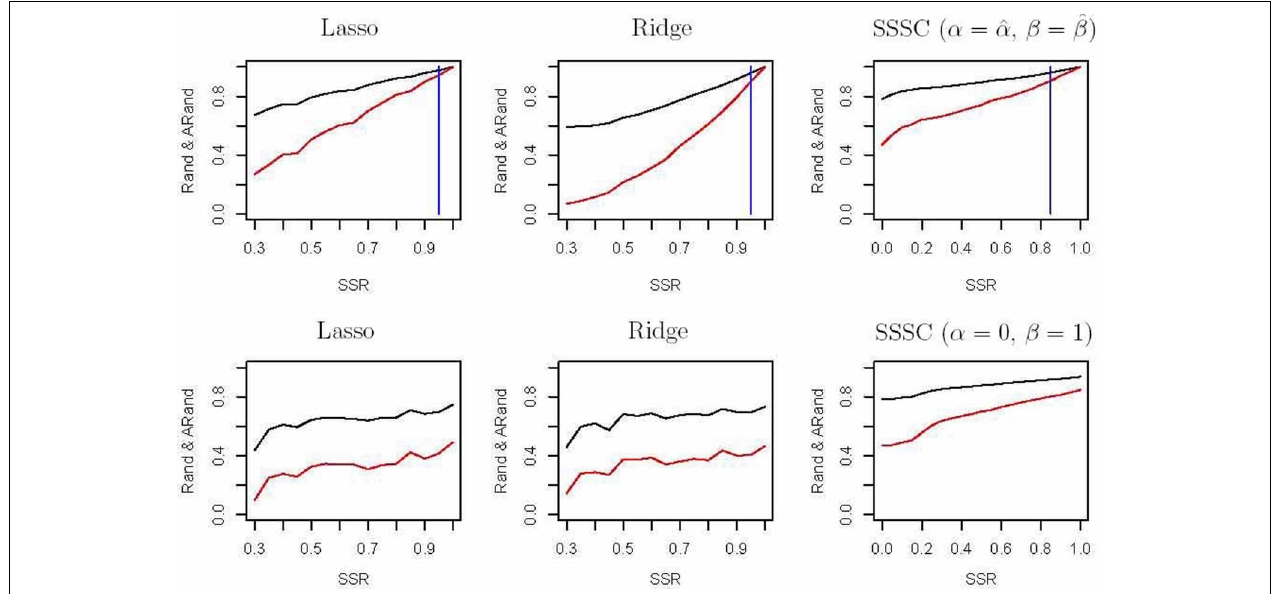
FIGURE 4 | Rand indices (black) and adjusted Rand indices (red) between the true subgroups and the SSSC or classification results. A vertical blue line indicates the point of SSR, at which the Rand and adjusted Rand are both bigger than 0.90 for the first time. The top